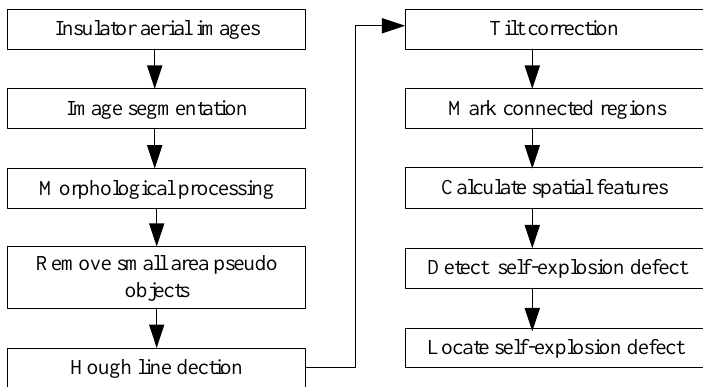
Figure 1. Flow chart showing the insulator self-shattering defect detection method.